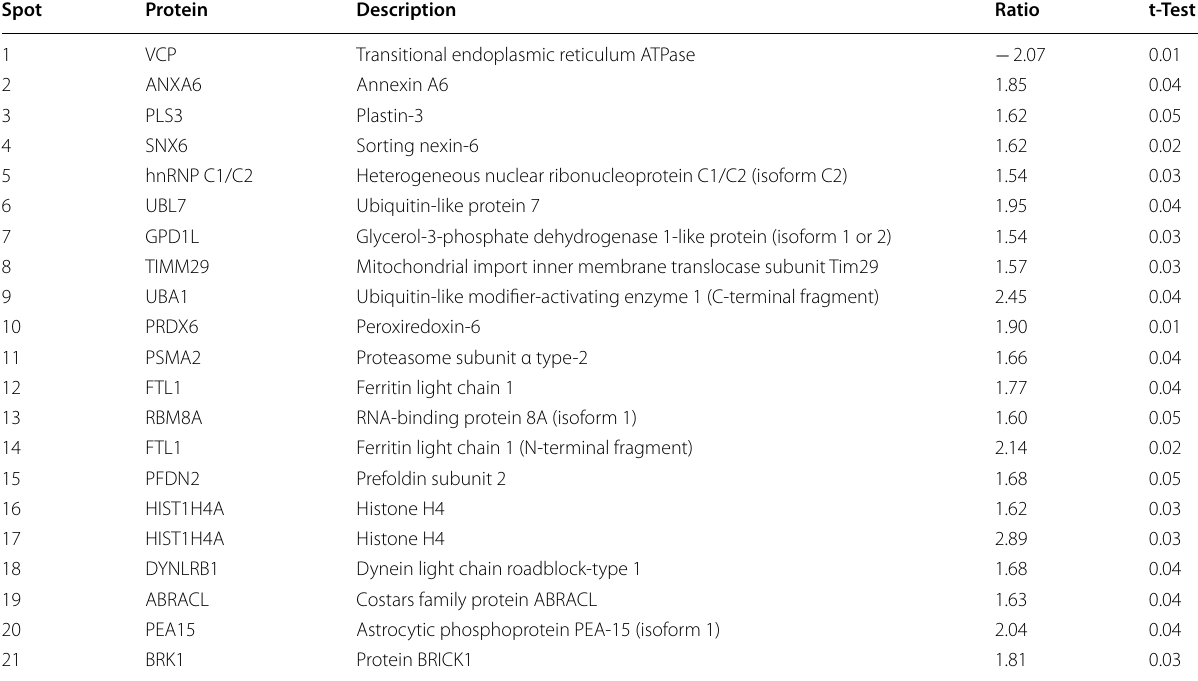
The ratio indicates the change of the normalized spot volumes in Nhlrc2 FINCA/ − in comparison to Nhlrc2 + / + NPCs